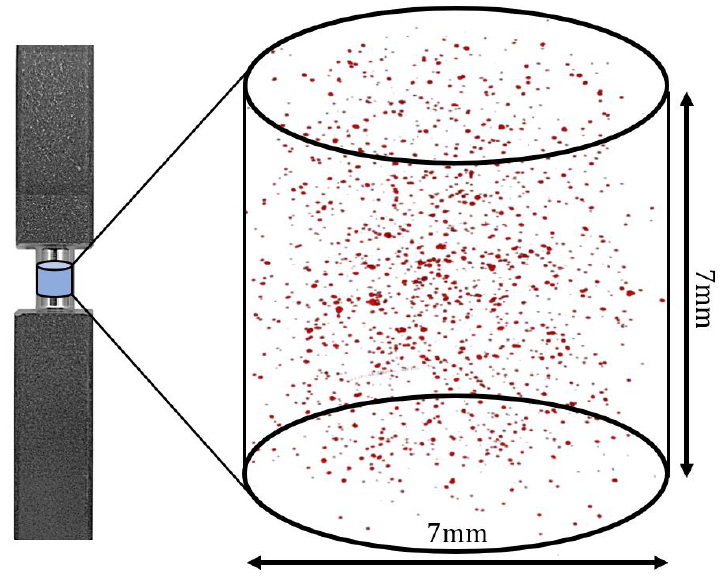
Figure 1. Defect population distribution measured via X-ray CT of a specimen containing a high defect density before undergoing standard HIP [18]. Note: the midsection of specimens were reduced prior to scanning for improved scan time and noise reduction.